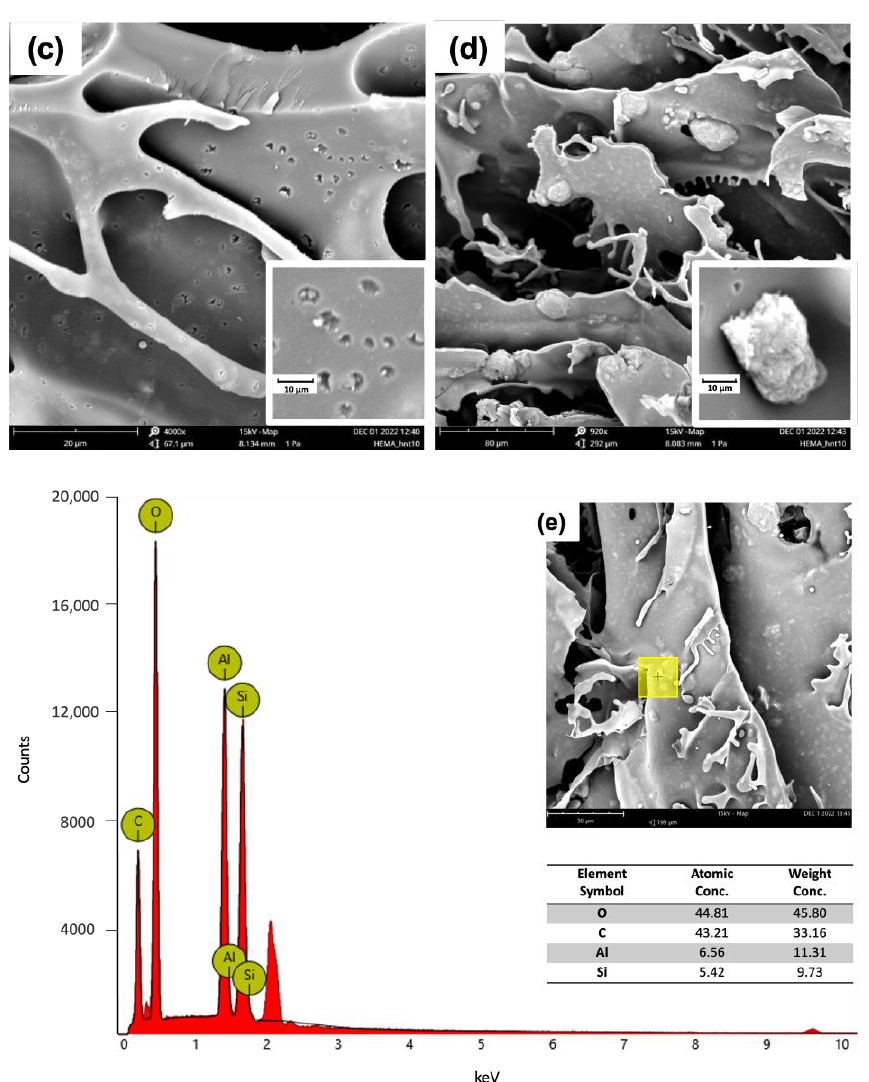
Figure 5. SEM images: ( a ) Cryogel of HEMA; ( b ) Cryogel of HEMA-HNT/Thy; ( c ) halloysite nanotubes inclusions; ( d ) halloysite aggregates. ( e ) EDX analysis of a portion (yellow square) of HEMA-HNT/Thy cryogel. The unlabeled peaks at 2.1 and 9.6 keV correspond to gold, which is used to confer conductivity.